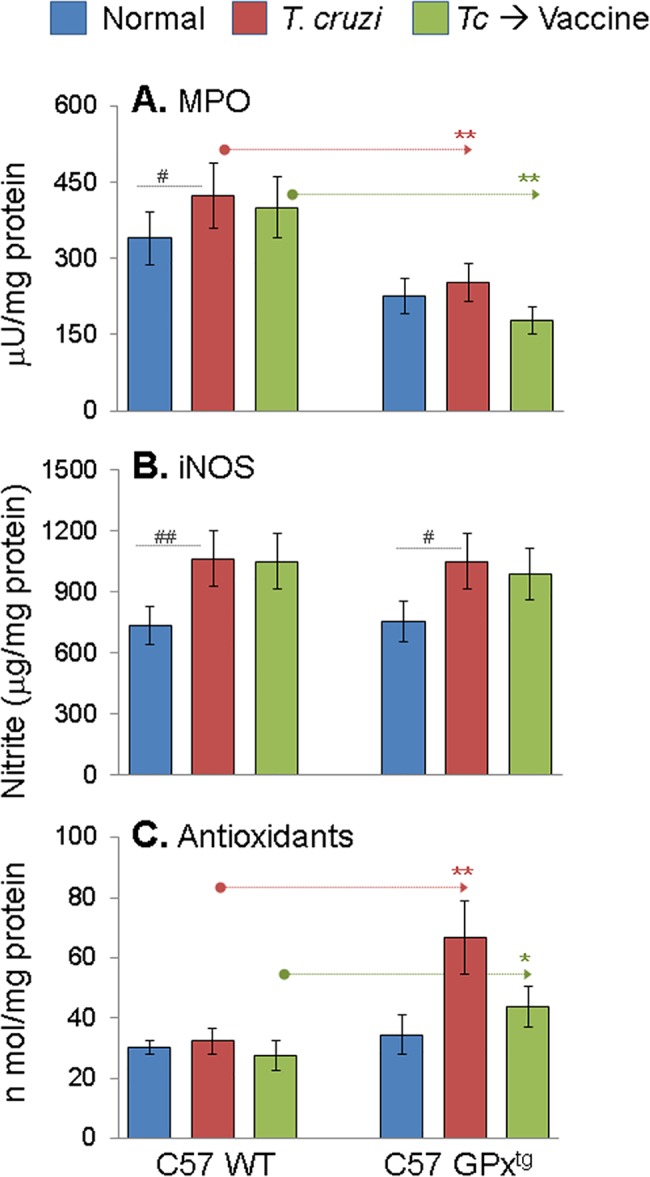
Inflammatory and antioxidant state in GPxtg and WT mice during chronic Chagas disease (± therapeutic vaccine).Mice (GPxtg and WT) were infected, vaccinated and harvested during chronic disease phase as in Fig 1. (A) Myeloperoxidase (MPO) activity in plasma by dianisidine-H2O2 method. (B) Nitrite content in reduced plasma samples, an indicator of inducible nitric oxide synthase (iNOS) activity, was determined by Griess reagent assay. (C) Total antioxidant capacity in heart homogenates of infected and infected/vaccinated mice was determined as detailed in Materials and Methods.